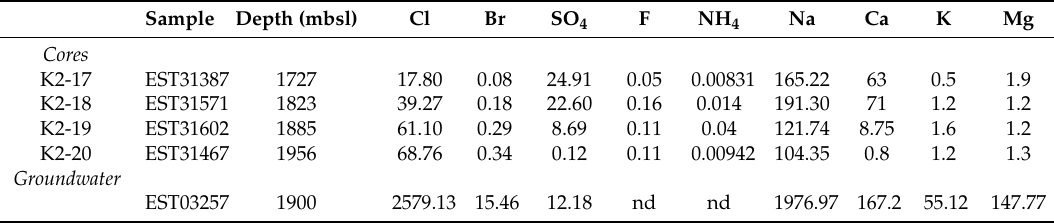
Table 2. Geochemical analyses of pore water from Triassic sandstones and Triassic water (concentration in mM). Data of groundwater from Triassic formation were obtained from Rebeix et al. [48].